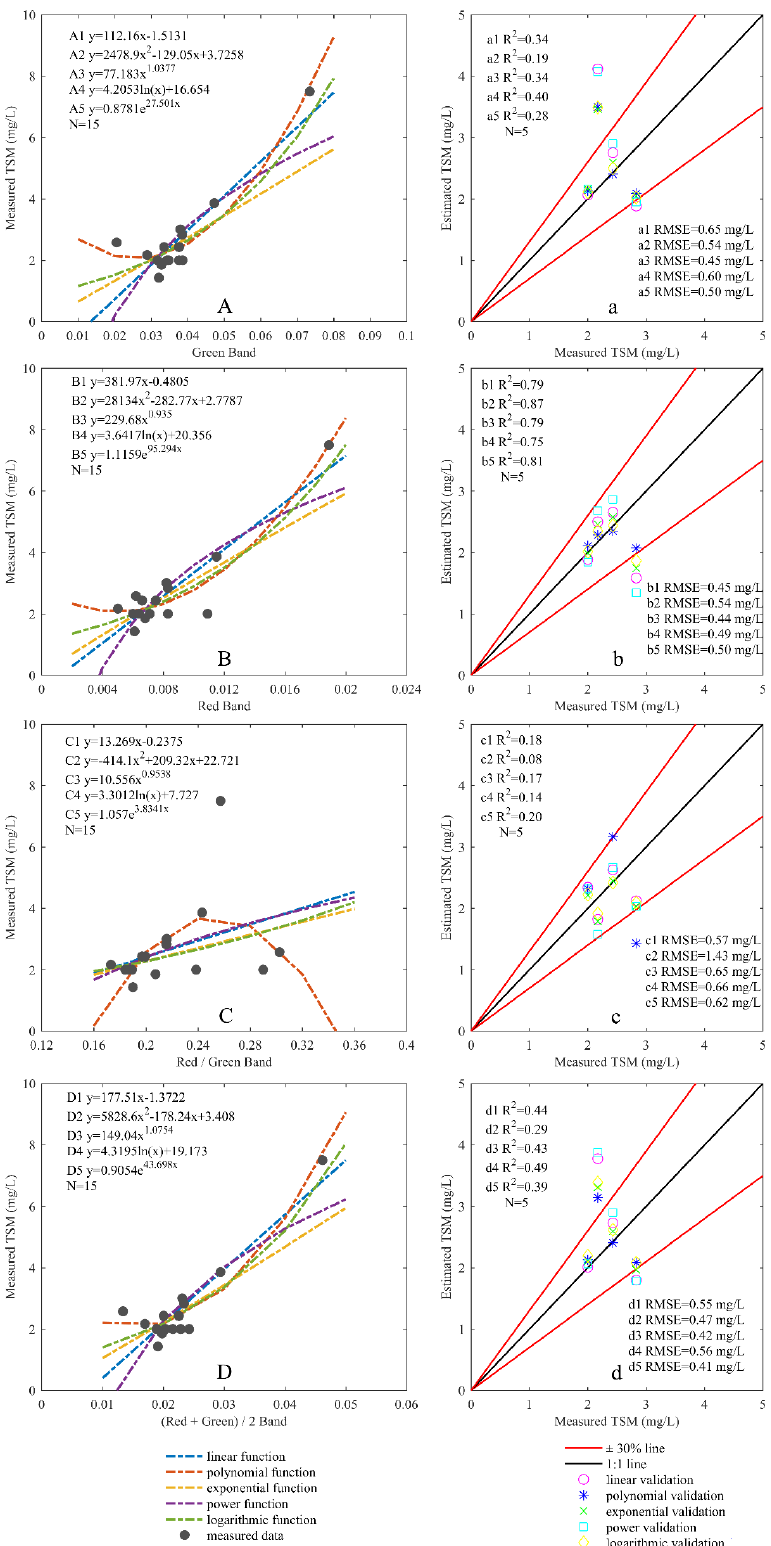
Figure 4. The calibration and validation results of TSM retrieval models are based on 20 in-situ measurements, including linear, power, exponential, logarithmic, and polynomial functions. ( A – D ) represent the calibration result of Rrs(Green), Rrs(Red), Rrs(Red)/Rrs (Green), (Rrs(red) + Rrs(Green))/2, and ( a – d ) represent the corresponding validation results.